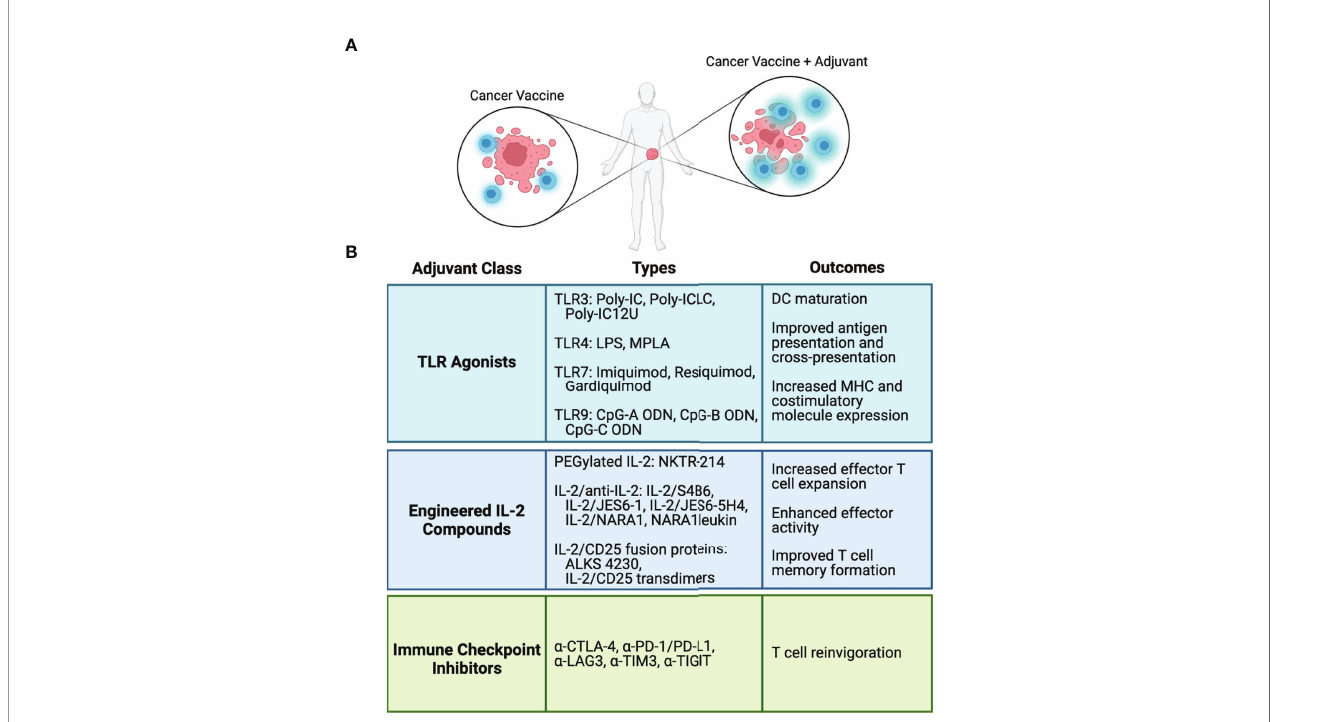
FIGURE 2 | Adjuvants and immune modulators to enhance cancer vaccines. (A) Cancer vaccine antigens stimulate antigen-speci fi c T cell-mediated antitumor responses. Adjuvants and immune modulators fortify the T cell response to cancer vaccines. (B) Classes of adjuvants and immune modulators, representative types in each class, and biological outcomes from each